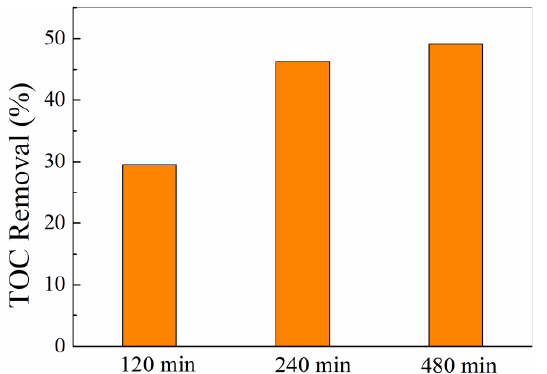
Figure 12. Time evolution of TOC during the RhB decoloration under visible light irradiation with H 2 O 2.